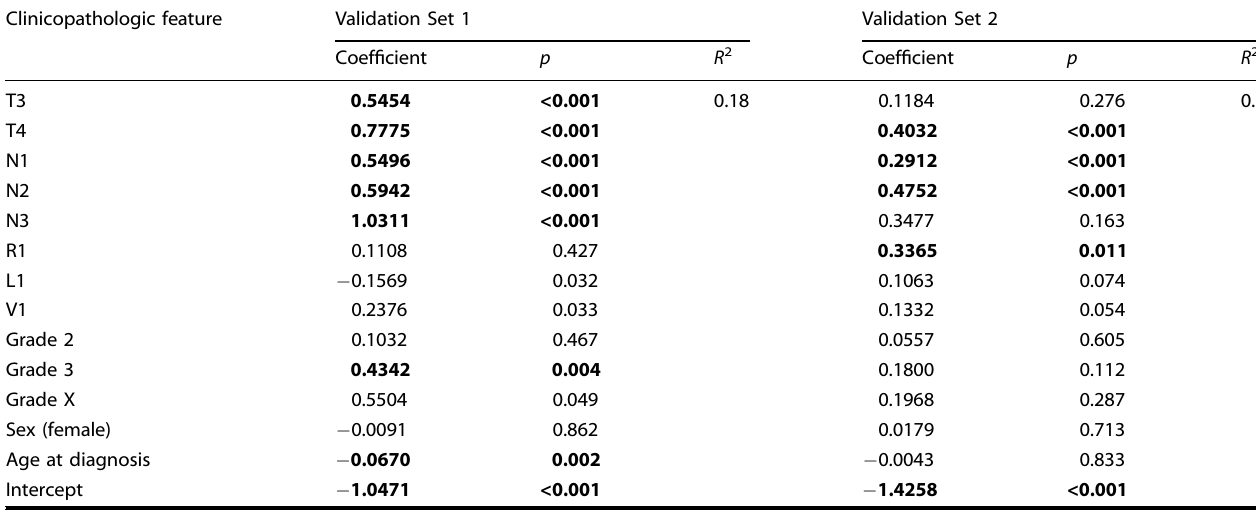
Table 4. Multivariable regression of case-level DLS score using clinicopathologic features as input. Clinicopathologic